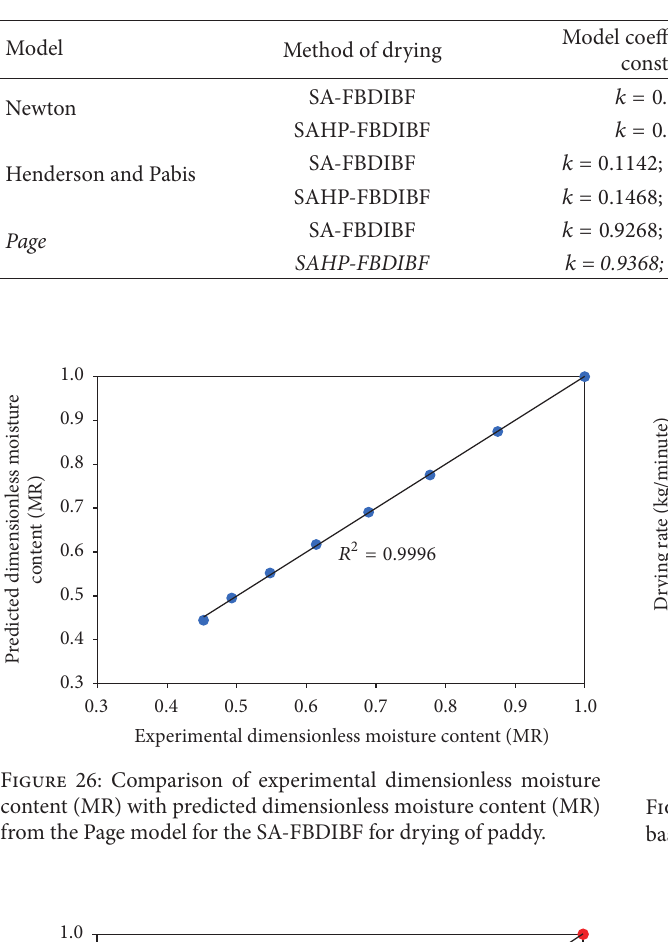
Table 4: Statistical results mathematical modelling of drying curves.